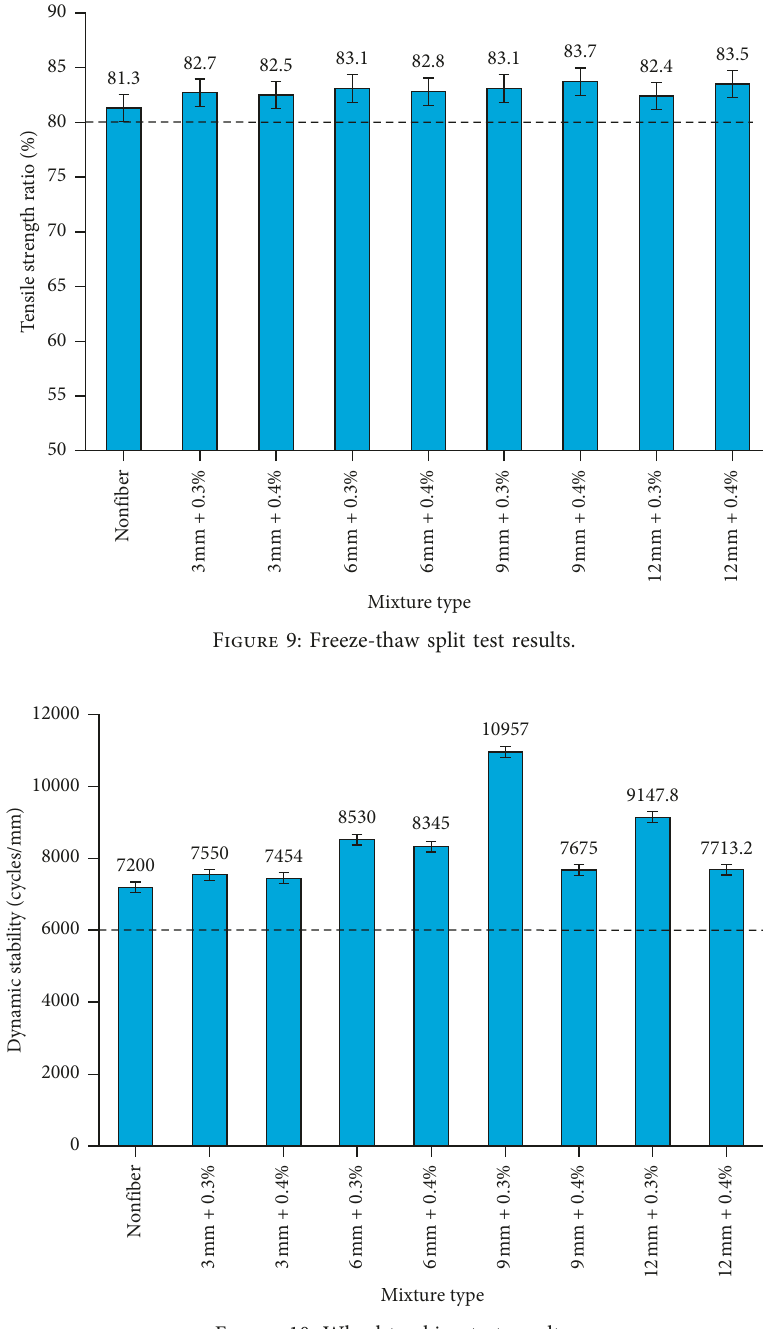
Figure 10: Wheel tracking test